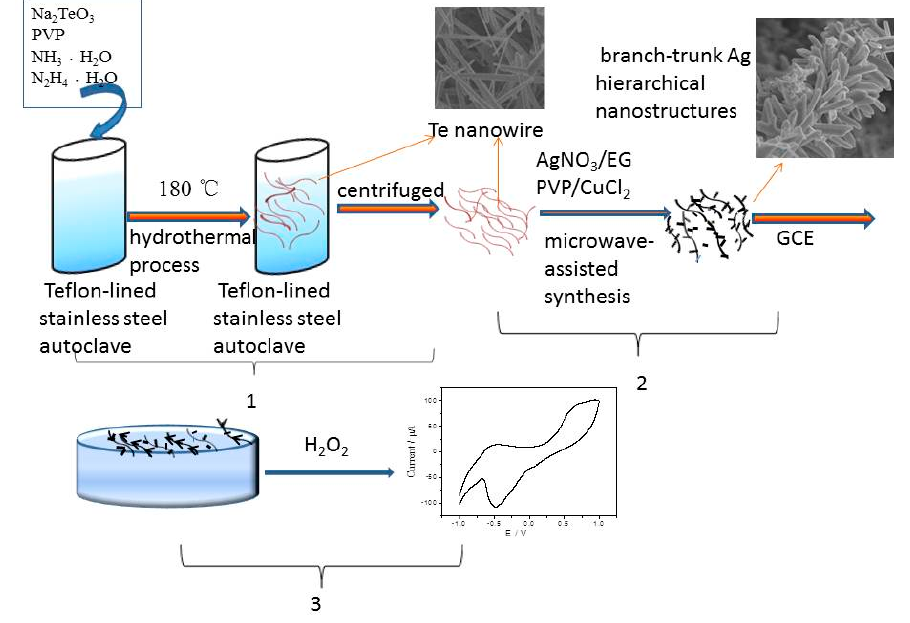
Figure 3. Schematic illustration of the formation mechanism of branch-trunk Ag hierarchical nanostructures and branch-trunk Ag hierarchical nanostructure-modified GCE used for detecting H 2 O 2 .